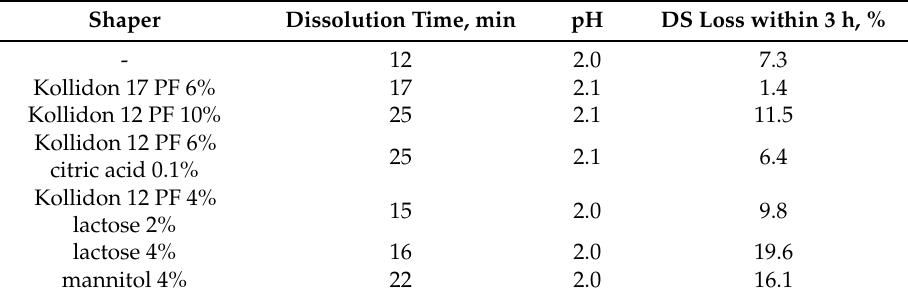
Table 3. The impact of shapers on the stability of ormustine.